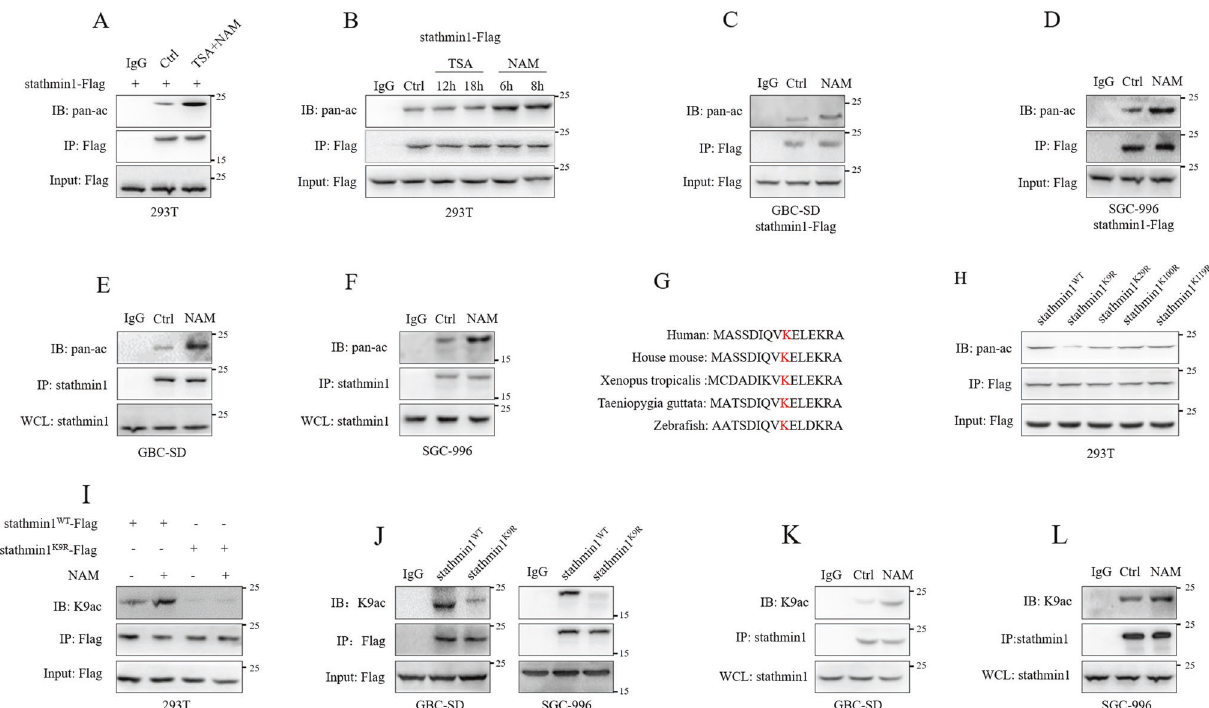
Fig. 1 Stathmin1 was acetylated at K9 in GBC. Immunoprecipitation detection of the acetylation of exogenous stathmin1, A , B after transfection of stathmin1-Flag plasmids to 293 T cells for 48 h with TSA and NAM treatment at indicated time, C , D in GBC-SD and SGC-996 stable cells with stathmin1 overexpression, E , F in GBC-SD and SGC-996 cells. G The amino acid sequence analysis around K9 in different of species. H Immunoprecipitation detection of the acetylation of exogenous stathmin1. Stathmin1 WT -Flag, stathmin1 K9R -Flag, stathmin1 K29R - Flag, stathmin1 K100R -Flag and stathmin1 K119R -Flag plasmids were transfected to 293 T cells for 48 h with TSA and NAM treatment. Immunoprecipitation detection of K9 acetylation of exogenous stathmin1 through K9ac speci fi c antibody, I after transfection of stathmin1 WT - Flag and stathmin1 K9R -Flag plasmids to 293 T cells for 48 h with NAM treatment, J in GBC-SD and SGC-996 stable cells overexpressing stathmin1, K , L in GBC-SD and SGC-996 cells. Results were shown as means ± s.d from at least three independent